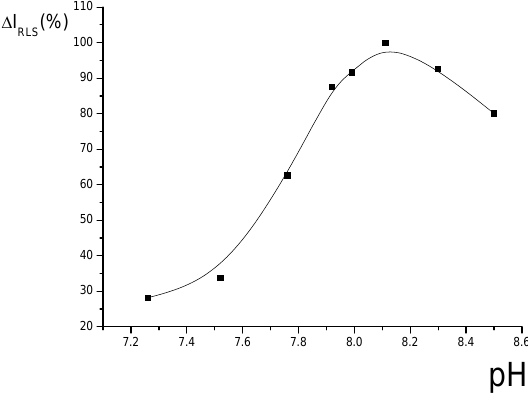
Figure 2 . Effect of pH on RLS intensity of Eu 3+ -nicotinic acid-fsDNA.